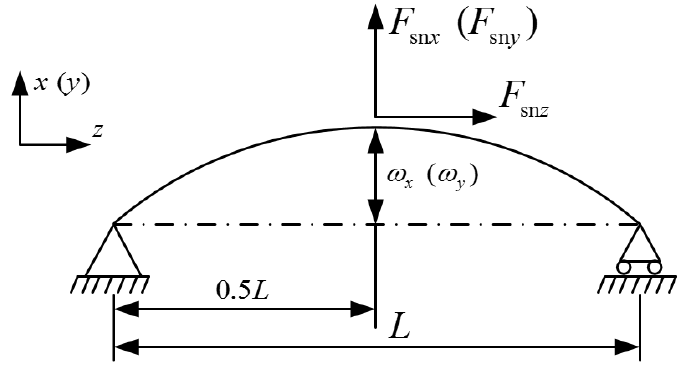
Figure 5. Bending deformation of screw shaft.